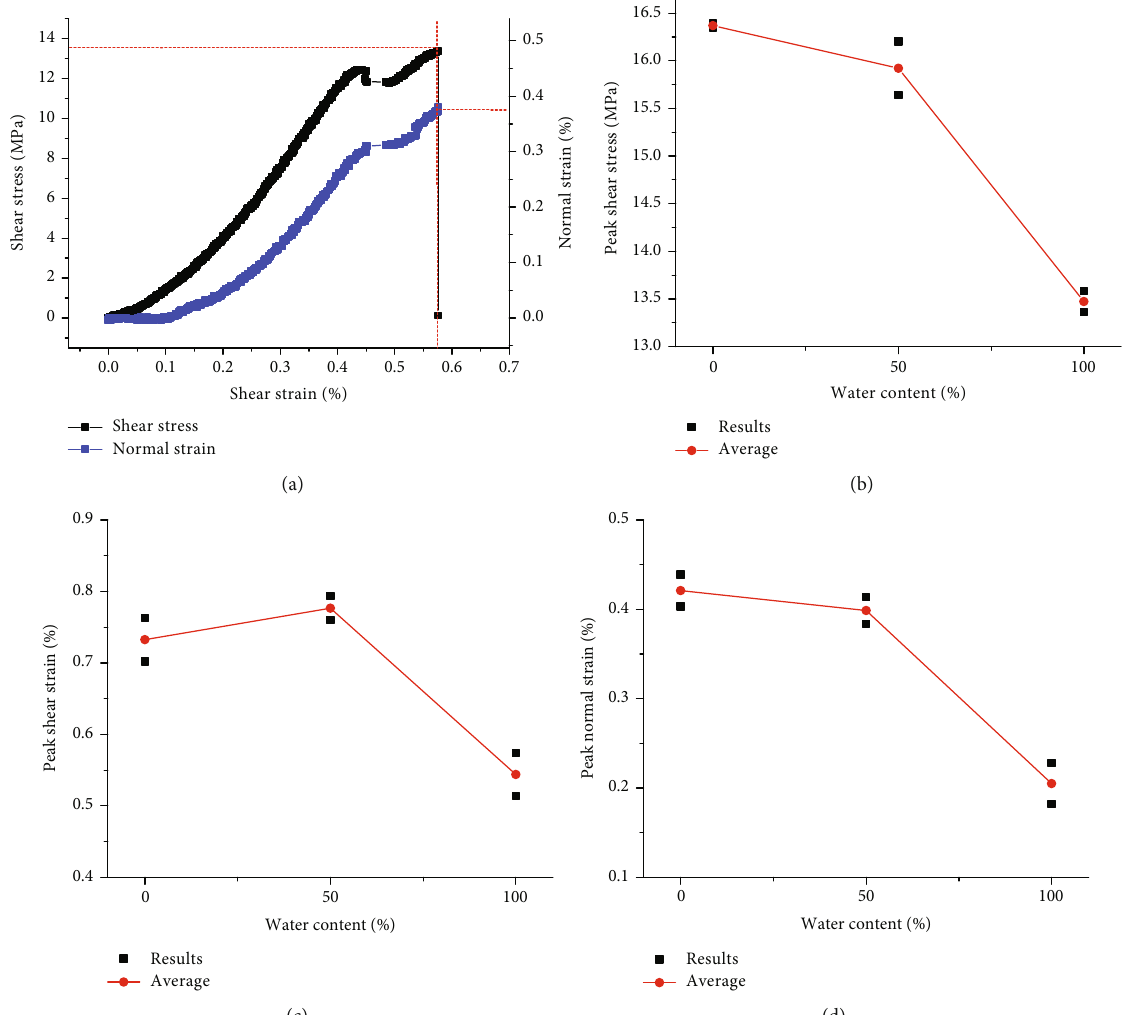
Figure 4: Variation curves of shear failure parameters under di ff erent water contents: (a) shear stress and normal strain vs. shear strain with ω = 100 % , (b) peak shear stress, (c) peak shear strain, and (d) peak normal w